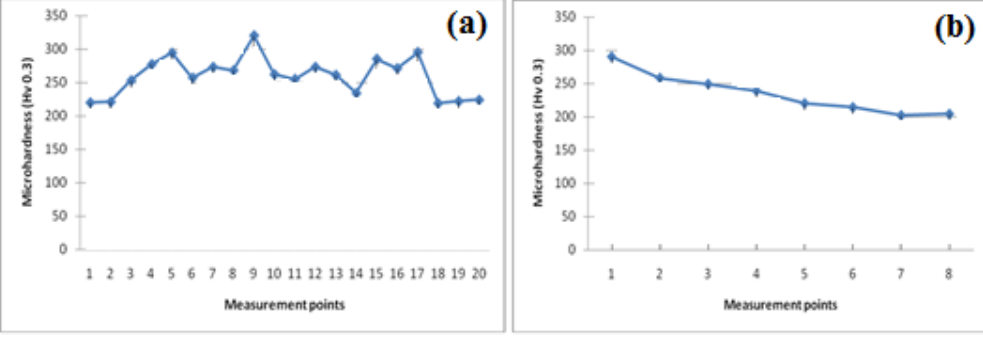
Figure 8. Microhardness test results of sample S3 ( a ) horizontal and ( b ) vertical.